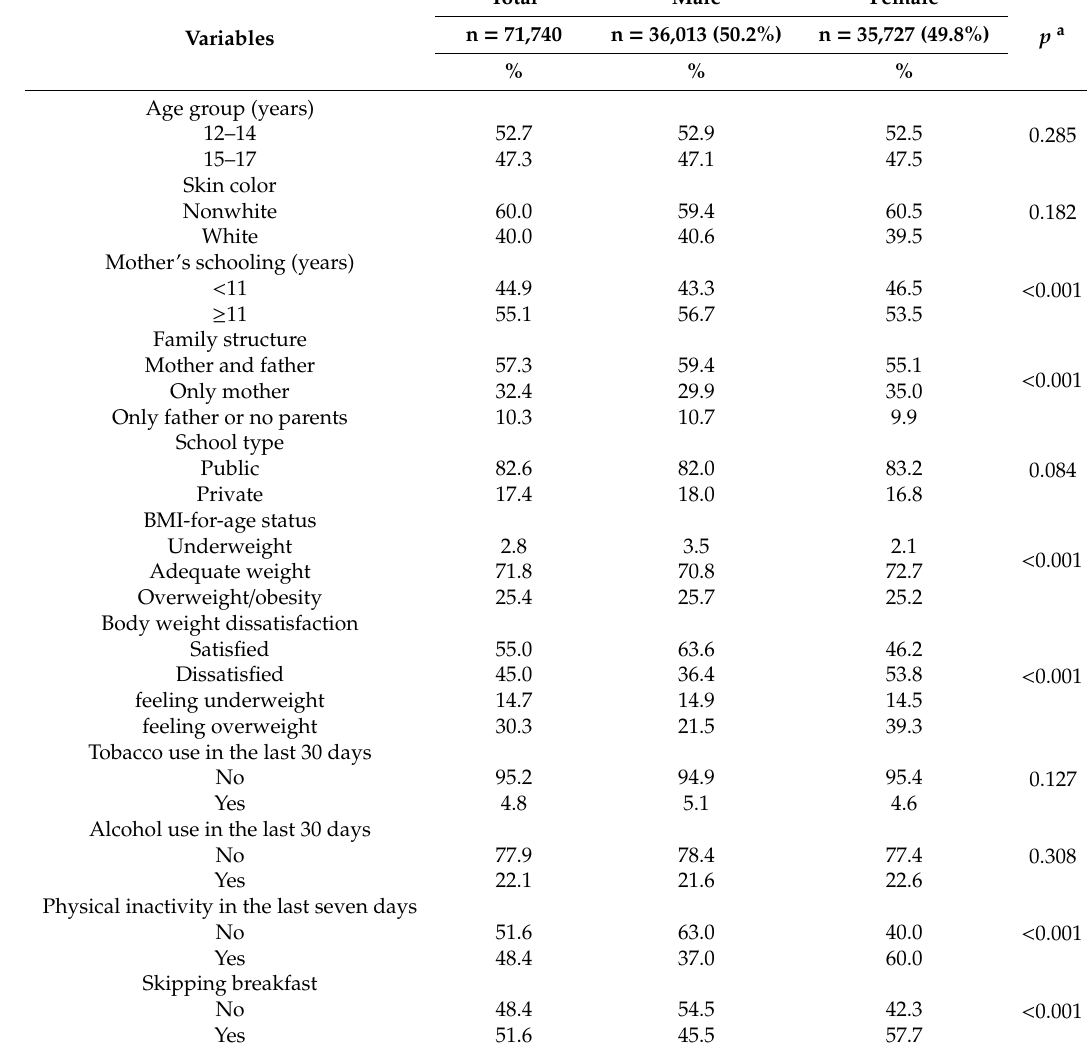
Table 1. Adolescent’s individual and sociodemographic characteristics, body weight dissatisfaction and health-risk behaviors in male and female